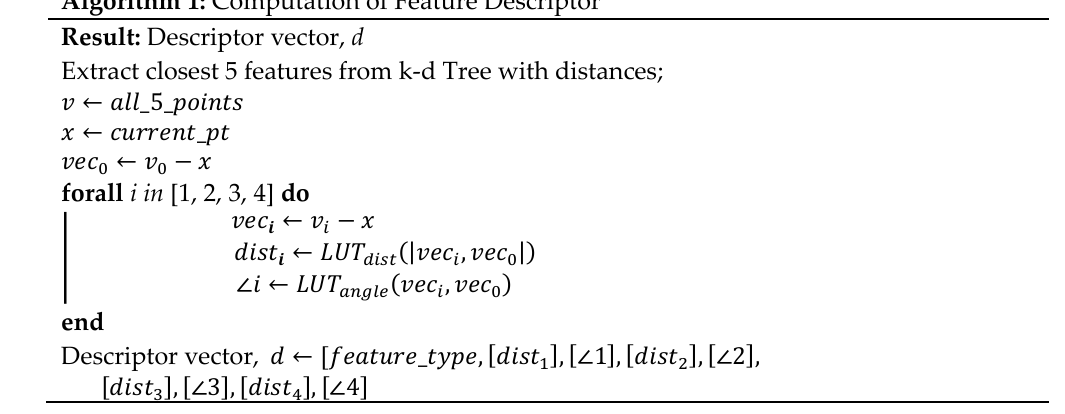
Figure 5. Angle calculation—In this figure, r is the macro-feature for which the description vector is being calculated, p is the closest macro-feature to r (taken as a base for the calculation), m is the macro-feature for which the angle relative to r is being calculated, and α is the angle between vectors a and b that connects r , p, and m .